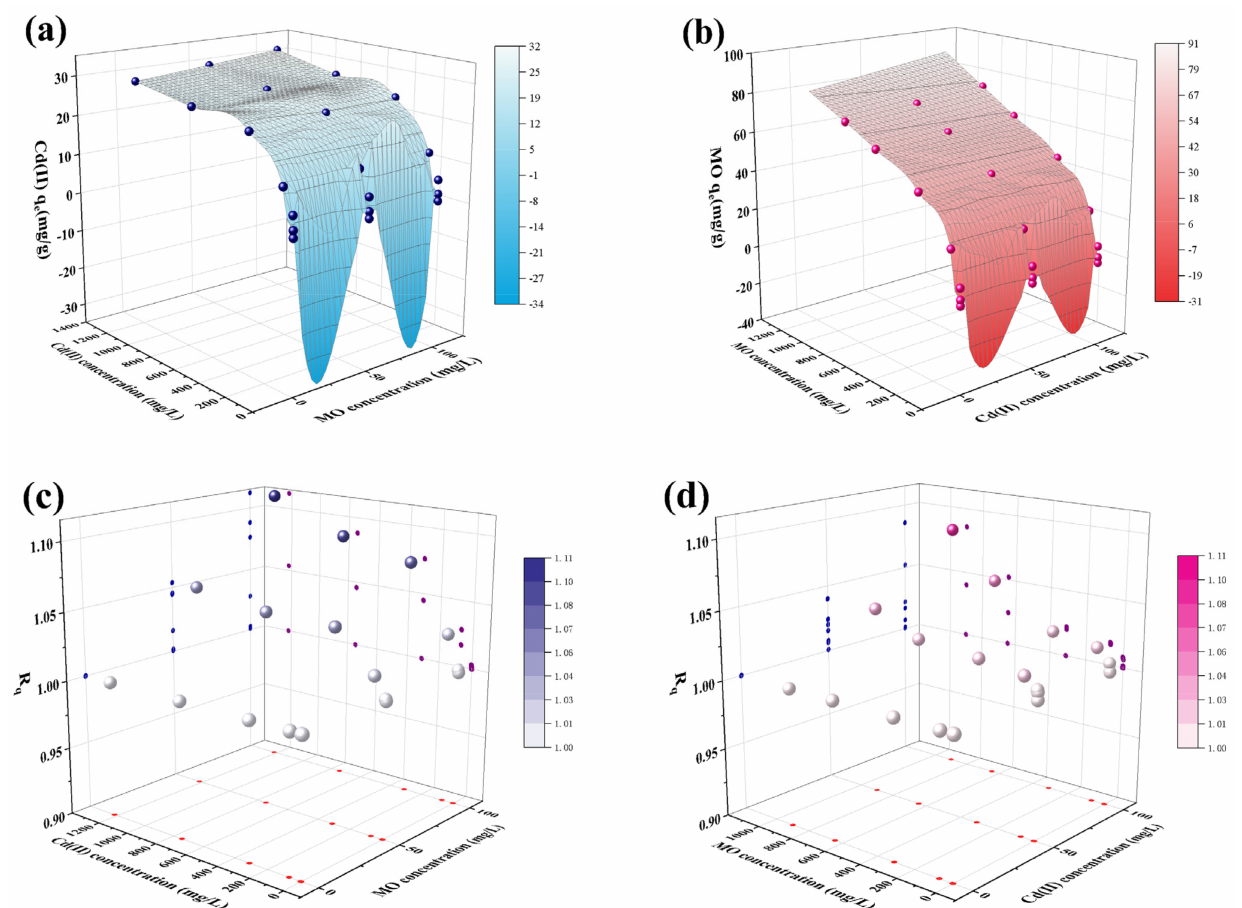
Figure 6. The adsorption of Cd(II) and MO in binary system by BNT-MBC: the influence of different initial concentrations on adsorption capacity ( a ) and R q ( c ) of Cd(II), on adsorption capacity ( b ) and R q ( d ) of MO (adsorbent dose 20 mg, contaminant solution 10 mL, pH 6, constant temperature 25 ◦ C, and reaction time 24